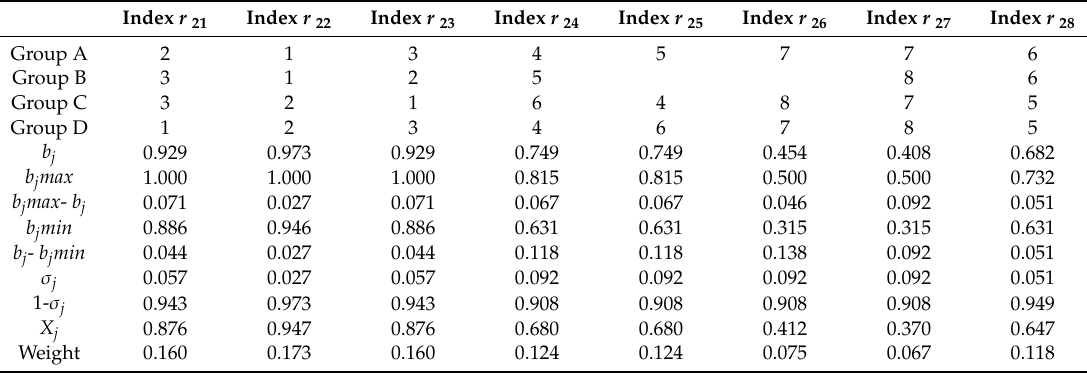
Table A3. Weight distribution of the second grade indexes of r